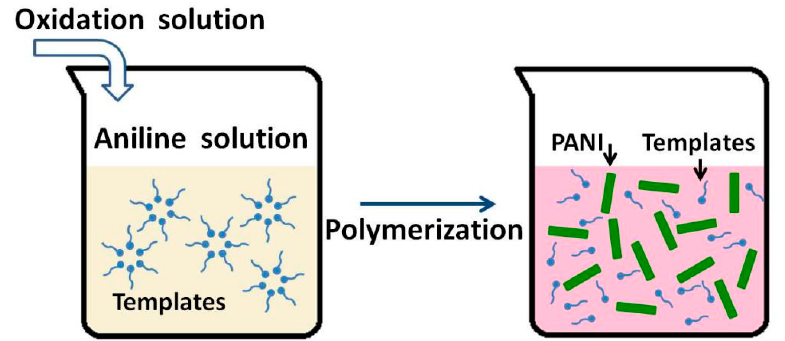
Scheme 5. The schematic diagram of the synthesis process of 1-D nano-PANI though soft template